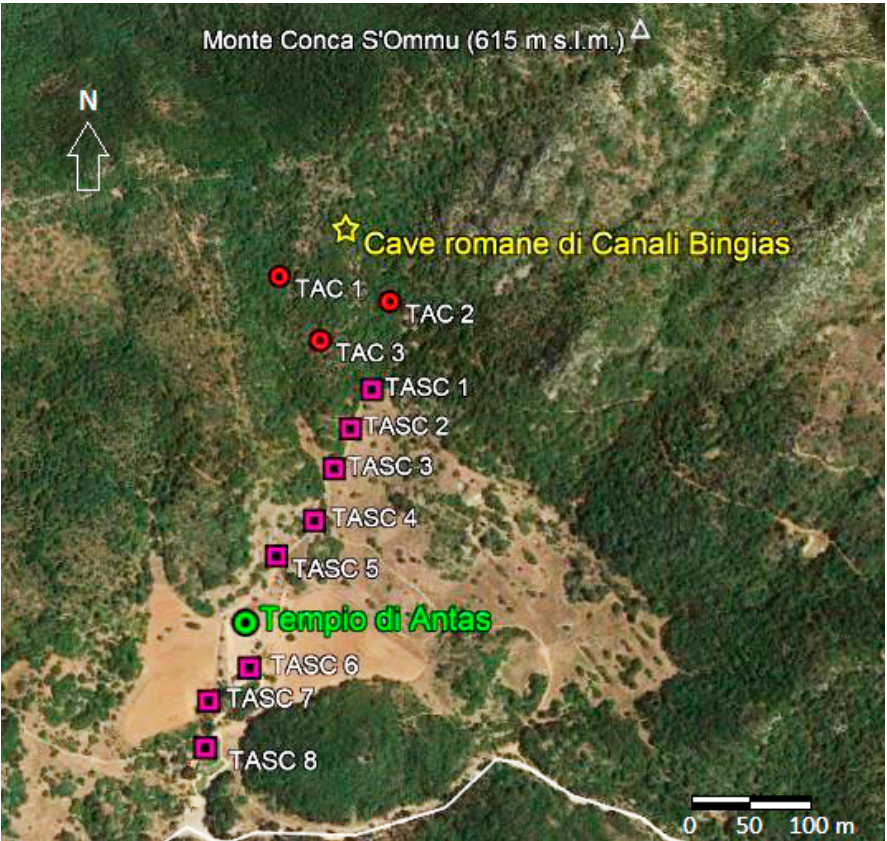
Figure 14. Aerial view of the area around the archaeological site of Antas (from Google Earth, modified, 2015). The yellow star indicates the position of the Roman quarries in locality called “Canali Bingias; the red circles indicate the sampling of the lithologies (samples TAC1, TAC2, TAC3) at south of ancient quarries; the purple squares indicate the sampling of outcrops (from TASC1 to TASC5) along the path that leads from the ancient quarries up to the temple, and the outcrops at South of Antas site (samples TASC6, TASC7, TASC8).